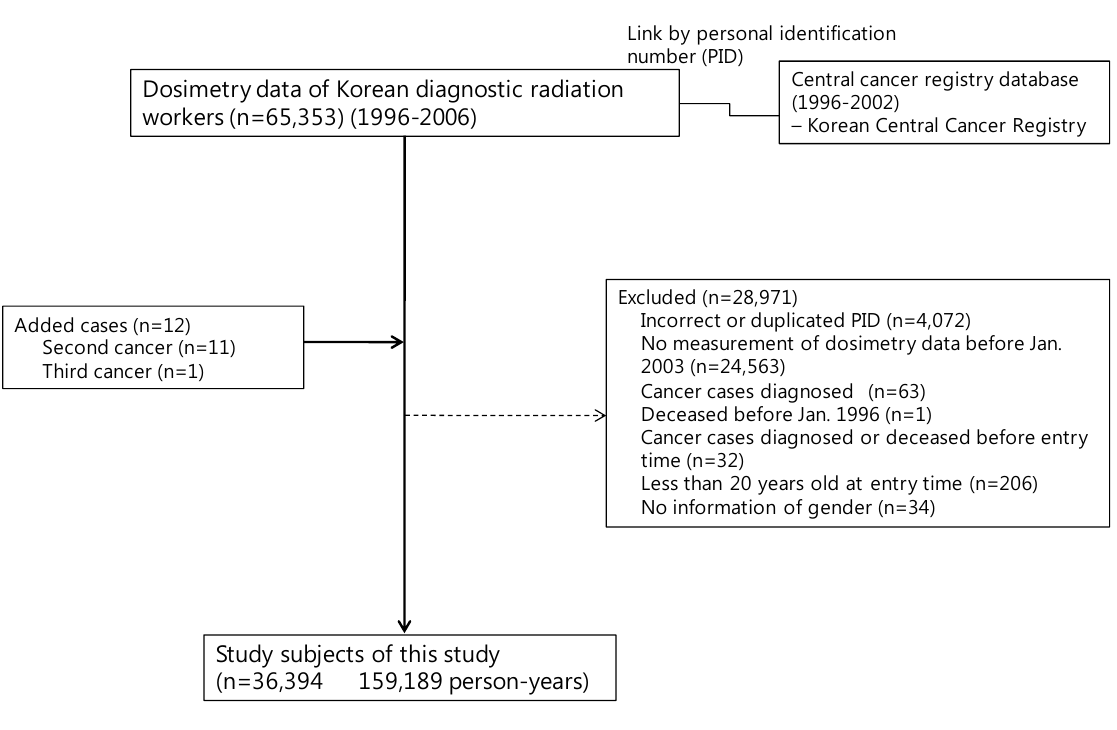
Figure 1. Selection process of the study subjects, Korea,